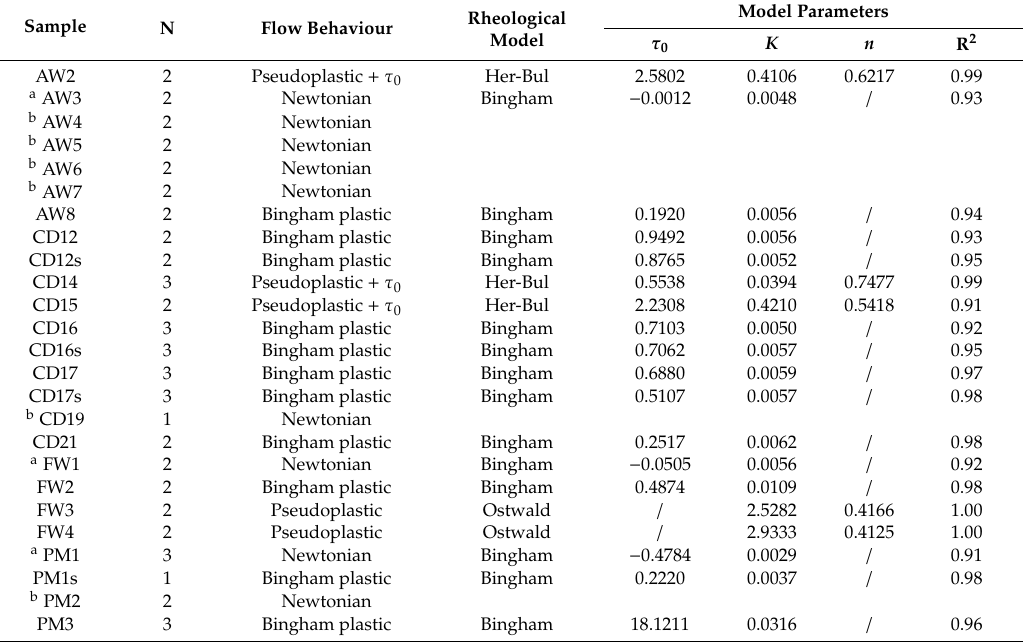
Table A1. Overview rheological modelling results. The sample names denote separate reactors. When the same reactor was sampled twice, the second sample is marked with an “s” behind the name.